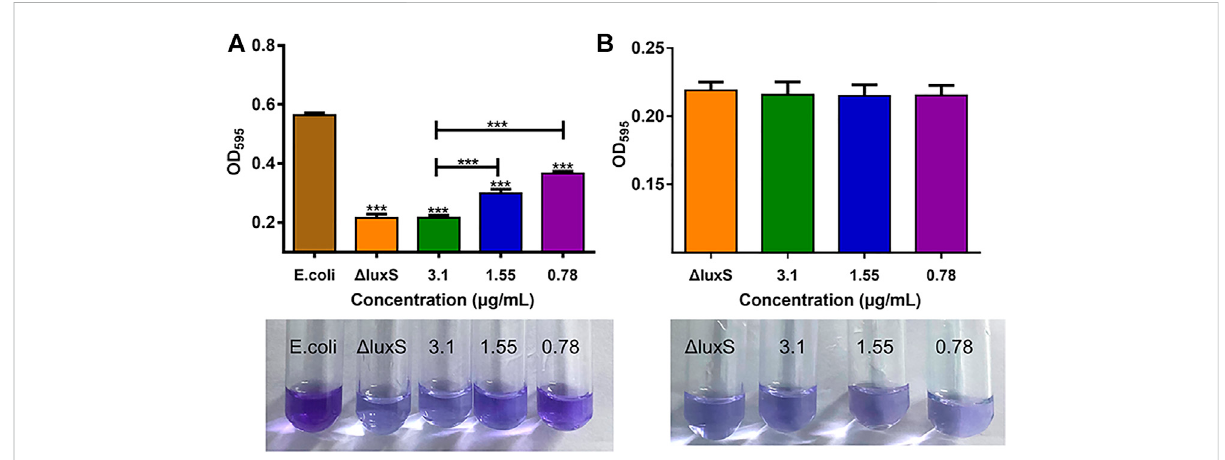
FIGURE 2 Different in fl uencing factors on the ability of bacterial bio fi lm formation. (A) Effects of luxS deletion and 1,8-cineole in non-inhibitory concentrations (3.1, 1.55, 0.78 and 0 μ g/ml) on the bio fi lm formation ability of E. coli O101; (B) Effect of 1,8-cineole in non-inhibitory concentrations (3.1, 1.55, 0.78 and 0 μ g/ml) on bio fi lm formation of E. coli O101 without luxS gene. The results represent means ± standard deviations for three independent experiments. * p < 0.05, ** p < 0.01 and *** p < 0.001 versus the control